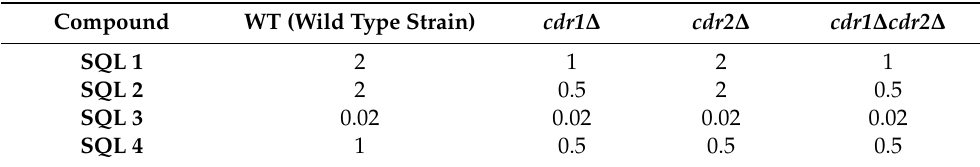
Table 2. The fractional inhibitory concentration (FIC) values for styrylquinoline compounds ( n = 3) that were tested.